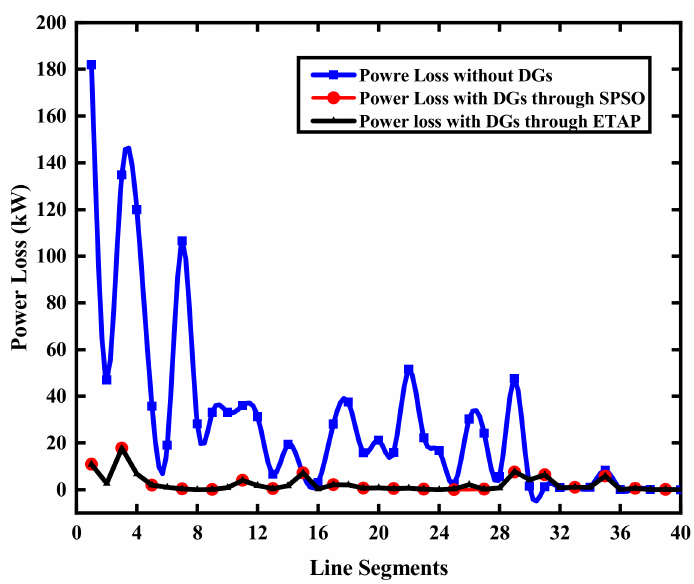
Figure 10. Segment power loss with and without